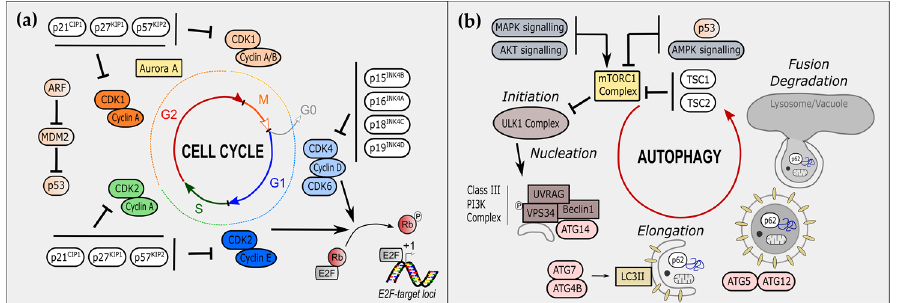
Figure 1. Cell-cycle regulators and autophagy players. ( a ) Overview of the main cell-cycle regulators. The cell cycle is divided into four steps: G0 (grey)/G1 (blue), S (green), G2 (red), and M (orange) phases. Cyclin-dependent kinases (CDKs) associate with cyclins along the cell cycle, allowing its progression. In early G1, CDK4 and CDK6 bind to cyclin D. In late G1, CDK2 is associated with Cyclin E. CDK4/6-cyclin D and CDK2-cyclin E phosphorylate RB leading to E2F release and transcription at E2F-target loci of cell-cycle associated genes. Cyclin A associates with S-phase CDK2 and G2/M-phase CDK1. CDKs are inhibited upstream by cyclin-dependent kinase inhibitors (CKIs). In G1 phase, INK family including p15 INK4B , p16 INK4A , p18 INK4C and p19 INK4D , inhibits CDK4/6-cyclin D. In other phases, CIP/KIP family including p21 CIP1 , p27 KIP1 and p57 KIP2 . Additional cell-cycle regulators include the Aurora Kinase A and the ARF/MDM2/p53 axis. ( b ) Overview of steps and actors of autophagy, called macro-autophagy. Initiation is mediated by the ULK1 complex, which mediates phosphorylation of VPS34 and formation of phagophore through nucleation and the association of UVRAG, Beclin-1 and ATG14. Elongation of phagophore is allowed by LC3II formation, by ATG7 and ATG4B, and LC3II association, by ATG5 and ATG12. Proteins can be also specifically targeted to phagophore by p62. Organelles, such as mitochondria, can be Fusion of phagophore with lysosome constitutes the last step, ultimately followed by degradation of internal components.